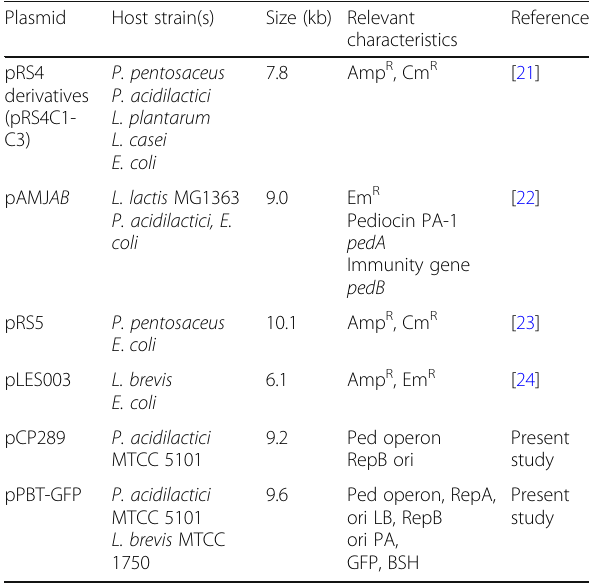
Table 6 Vectors used for cloning in strains of P . acidilactici